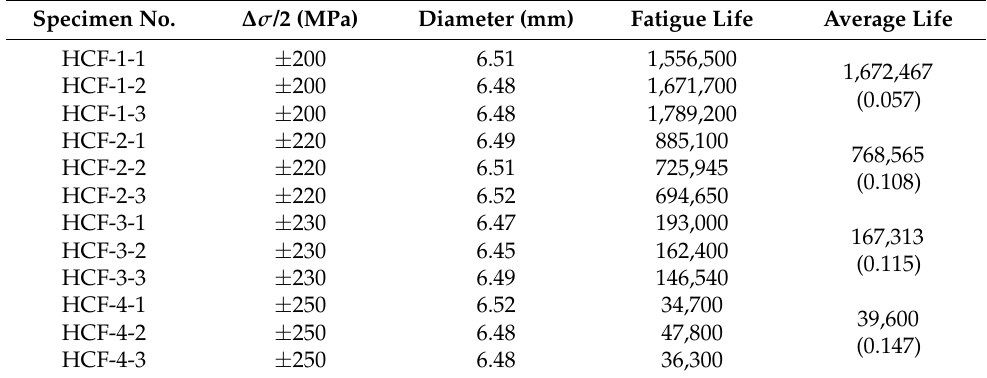
Table 2. Test results of the high cycle fatigue.